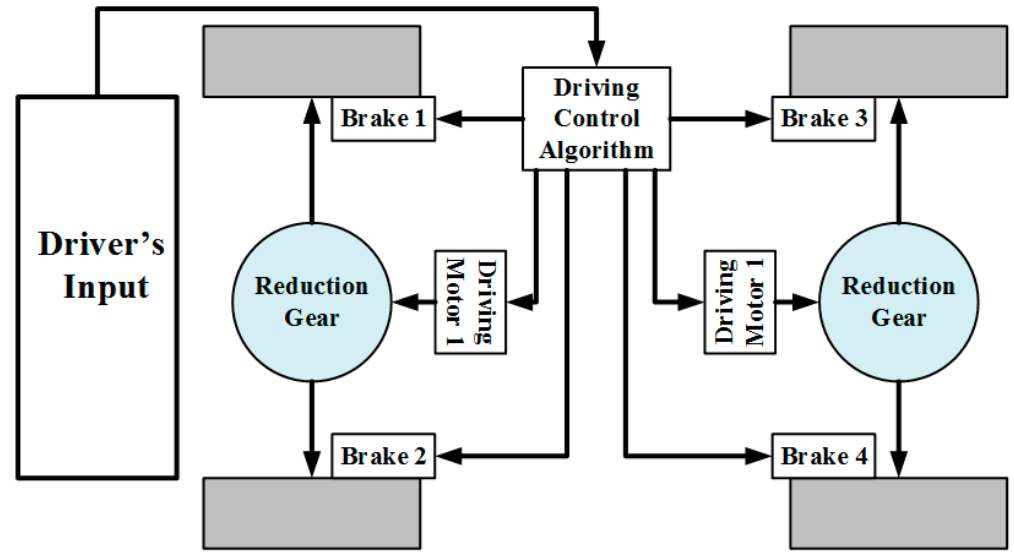
Figure 66. Main working components of the driving control system for four-wheel-drive EVs proposed by Juyong Kang et al. The driving control algorithm takes the driver’s inputs, and then determines the actions of the brakes and the motors according to the control mode [177].